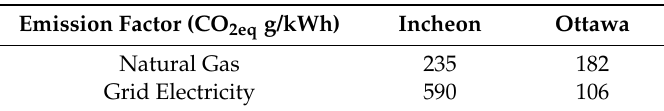
Table 1. CO 2 emission factors used in case